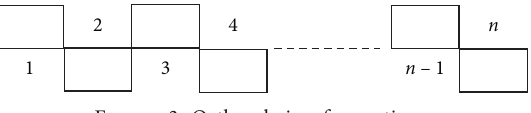
Figure 3: Ortho chain of n vertices.